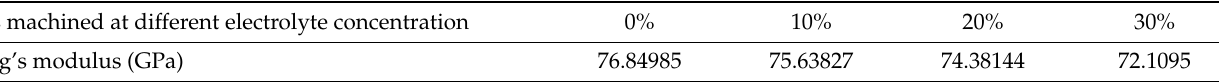
Table 1. Young’s modulus obtained from nanoindentation